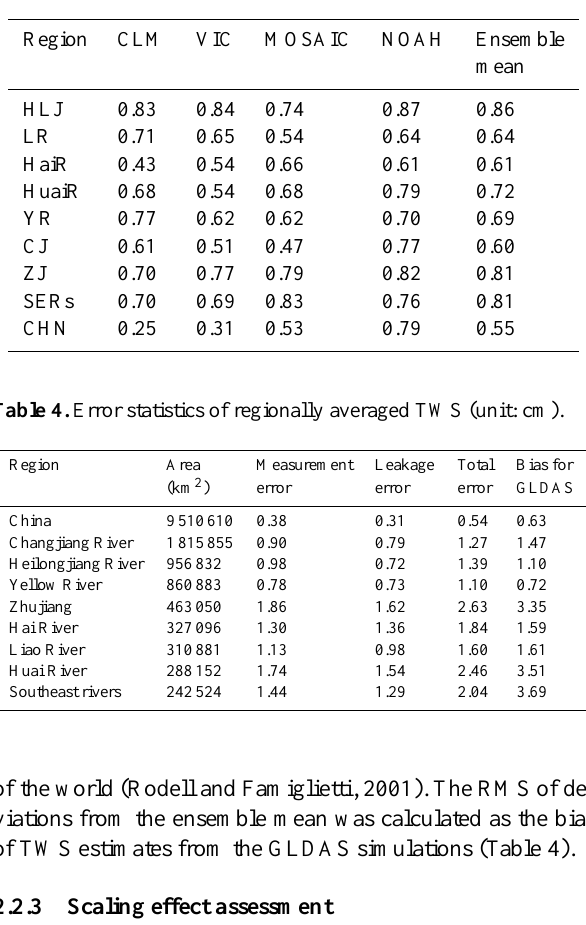
Table 3. Pearson correlation coefficients r between regionally aver- aged TWS from the scaled GRACE data and model simulations in China as a whole and eight of its basins.